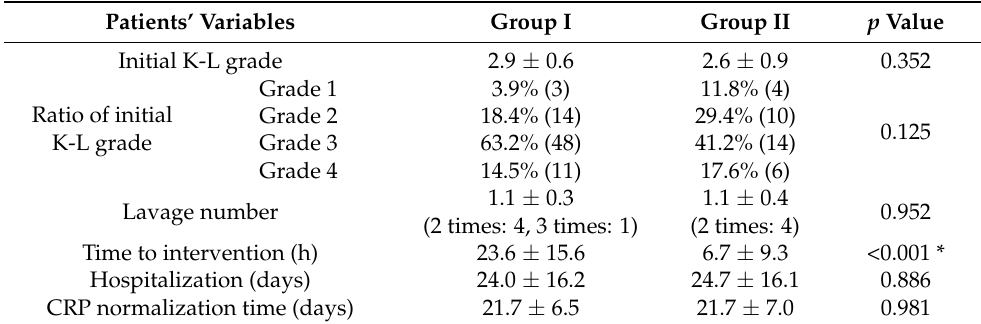
Table 3. Patients’ variables by study group.